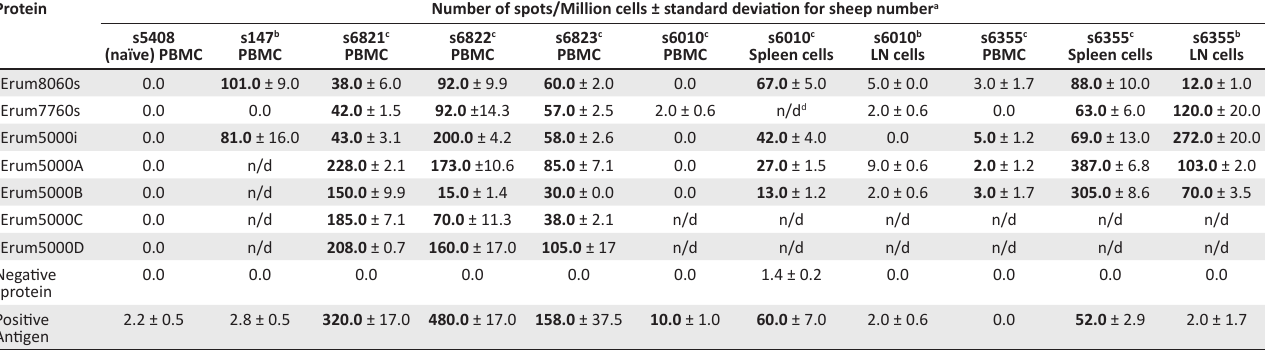
TABLE 4: IFN- γ by peripheral blood mononuclear cells, spleen cells and lymph node cells from heartwater immune sheep stimulated with recombinant proteins. Immune cells were obtained from a naïve sheep (s5408), needle infected sheep (s147, s6010) and tick infected sheep (s6821, s6822, s6823, s6355). Protein Number of spots/Million cells ± standard deviation for sheep number